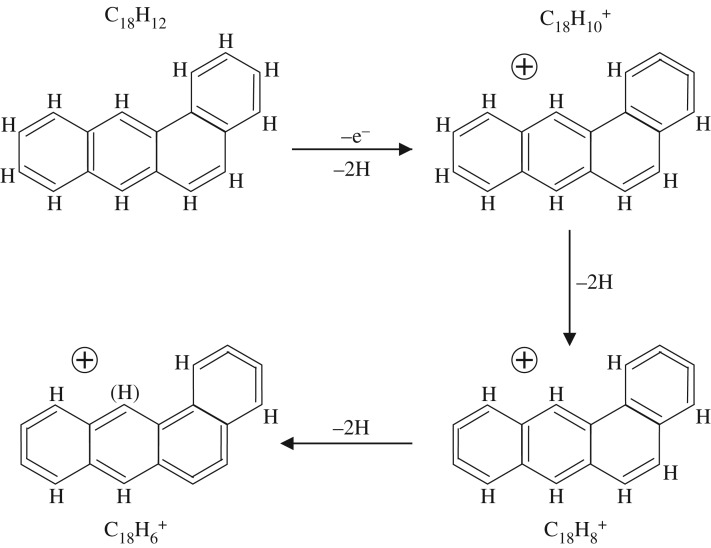
An alternative pathway for the dehydrogenation of C18H12 (S4) benz[a]anthracene to C18H 6+. The bracketed hydrogen atom, (H), in the lower left ion indicates a site than could be dehydrogenated to form a C18H 5+ ion.